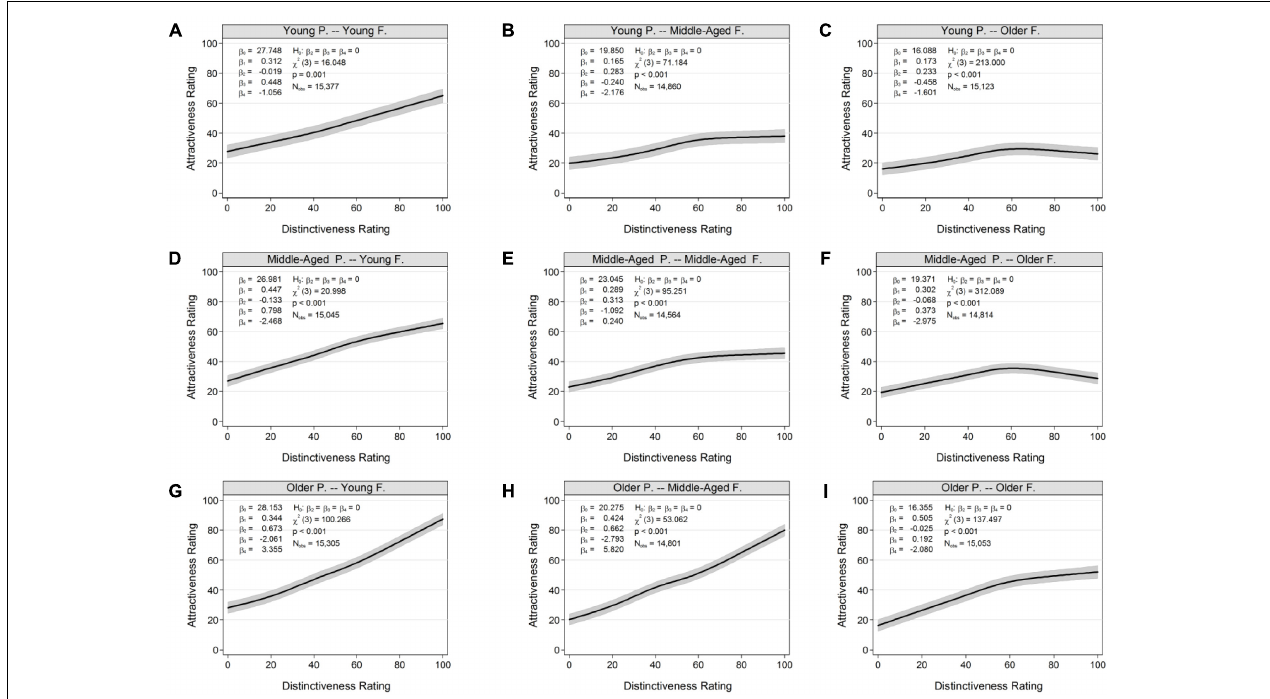
FIGURE 4 | Variations in the relation between attractiveness and distinctiveness ratings by age of perceiver and face: (A) Young Participants, Young Faces. (B) Young Participants, Middle-Aged Faces. (C) Young Participants, Older Faces. (D) Middle-Aged Participants, Young Faces. (E) Middle-Aged Participants, Middle-Aged Faces. (F) Middle-Aged Participants, Older Faces. (G) Older Participants, Young Faces. (H) Older Participants, Middle-Aged Faces. (I) Older Participants, Older Faces. Black lines show expected values of attractiveness, conditional on distinctiveness. Shaded areas indicate 95% confidence regions. Results were obtained from separate fits of multilevel restricted cubic spline models (Eq. 1). P = Perceiver; F =